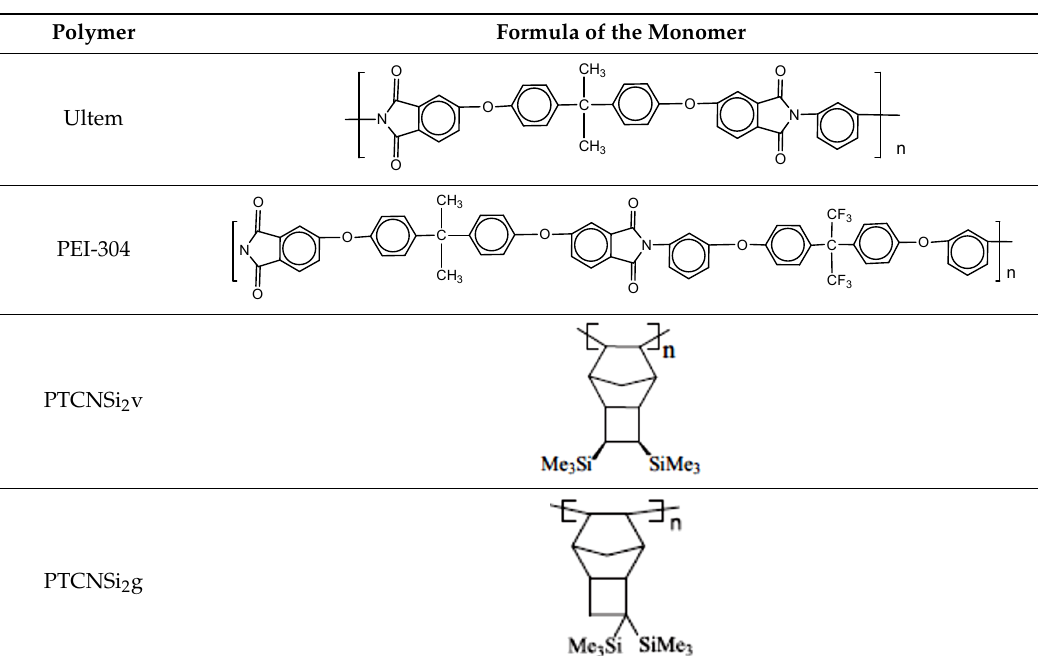
Table 2. Properties of glassy polymers.